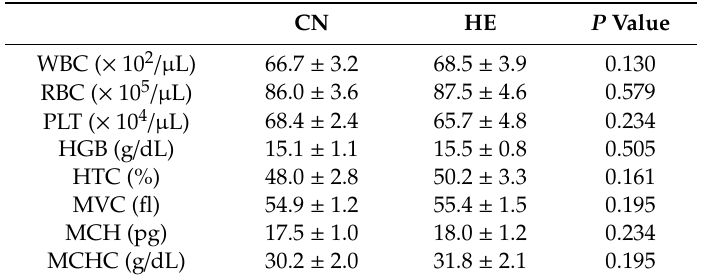
Table 2. Blood cell components for the control (CN) and heat-exposed (HE) rats.